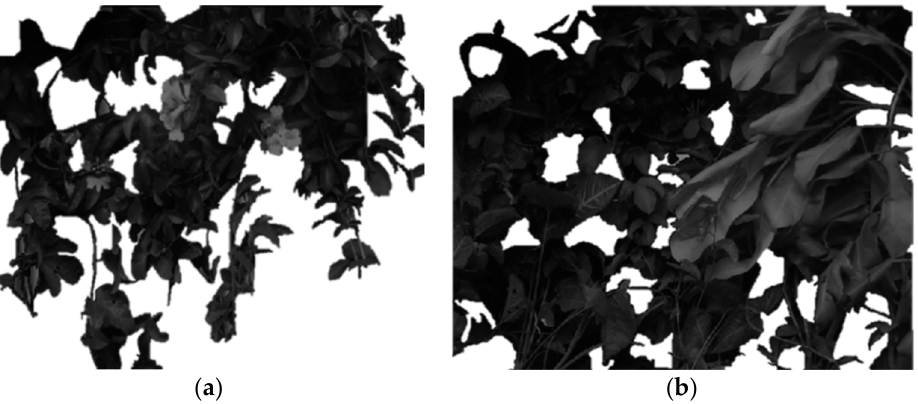
Figure 3. Chosen of leaves densitieson the green facade: ( a ) Leaves Densities50%; ( b ) Leaves Densities 90%.